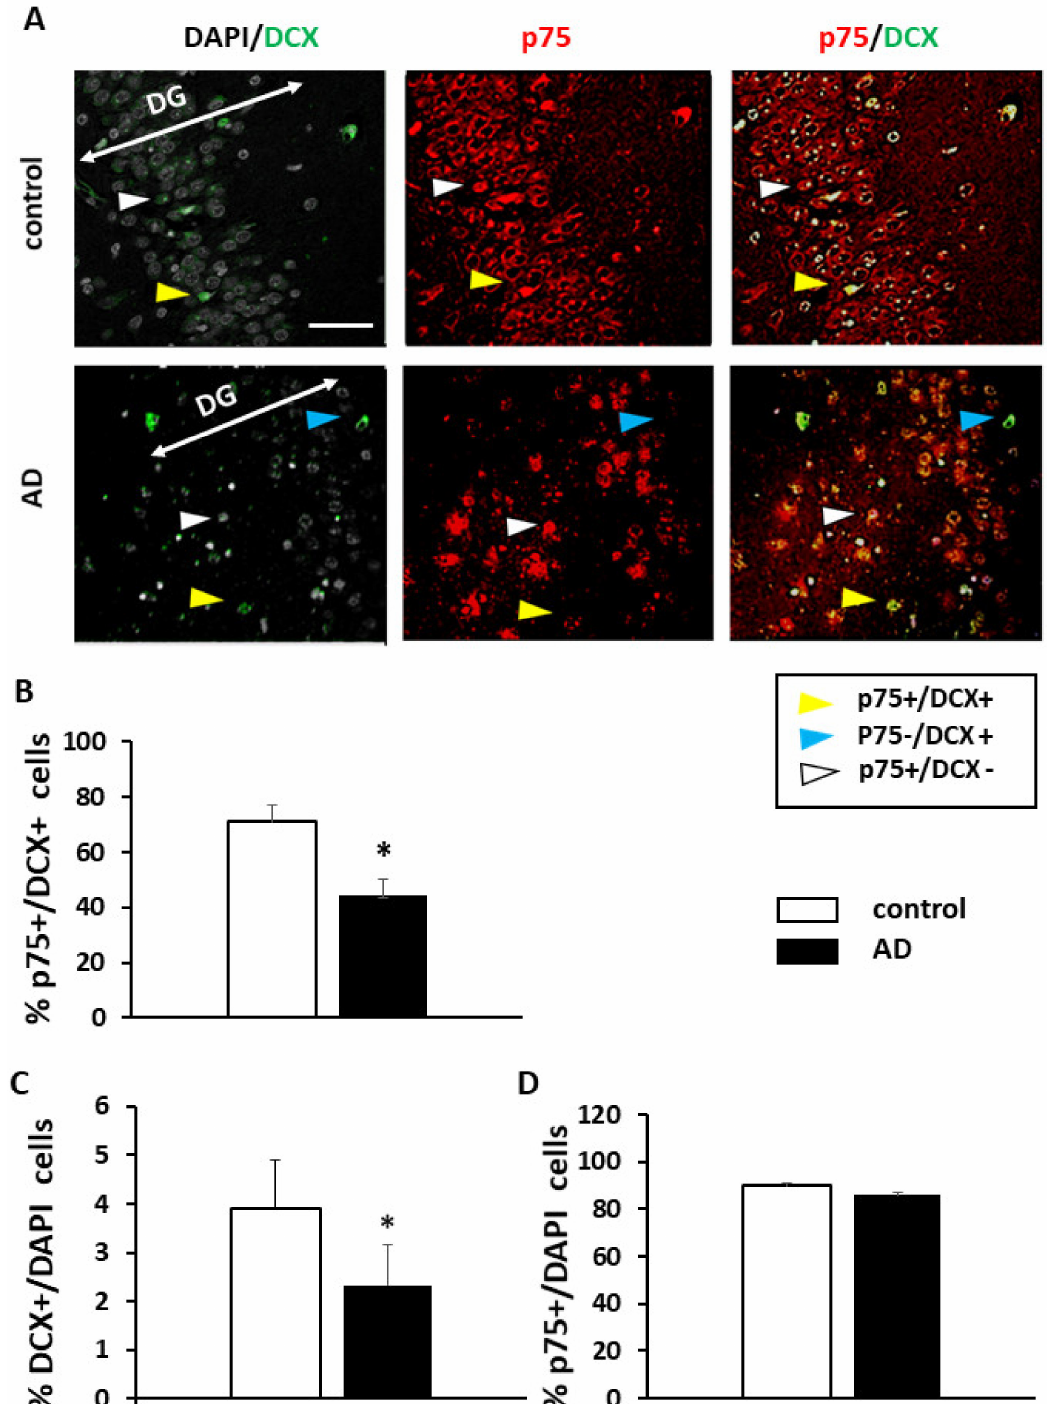
Figure 1. DCX and p75NTR expression in the human DG. ( A ) Representative confocal images of the neurogenic positive cells for DCX (green), p75NTR (red), and DAPI (grey) in DG of human samples of AD and control patients. Control shows greater colocalization of DCX and 75 than AD samples. Example of colocalization of DCX and p75 compared to AD samples (yellow arrow), DCX+ and p75- cells (blue arrow) and DCX-and p75+ cells (white arrow). Scale bar = 50 µ M. Bars show the quantification of p75 and DCX colocalization, expressed as the mean of % of p75NTR+ on the DCX + cells ( B ) % DCX+/DAPI cells ( C ) and % p75+/DAPI cells ( D ). Enough pictures at 40X were randomly selected to cover 300 DAPI positive neurons ( C ). AD shows a decreased colocalization of DCX and p75 with respect to controls. ( n = 3 control, n = 4 AD). p ≤ 0.05